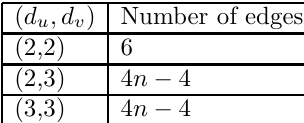
Table 1. The number of three types of edges of the graph T